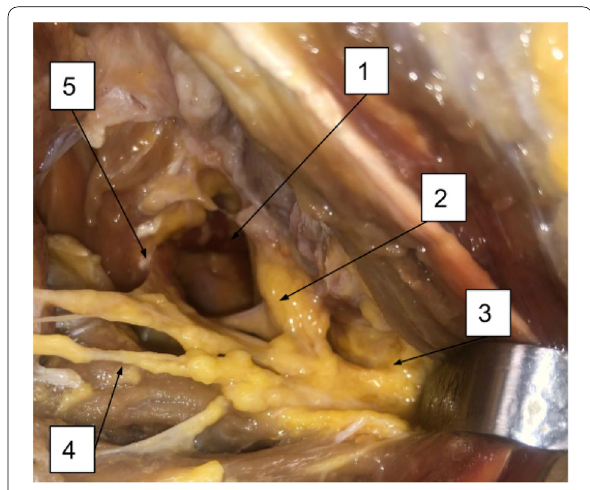
Fig. 6 Posterior approach. (1) Quadrangular space; (2) Axillary nerve; (3) Muscular branch to the deltoid muscle; (4) Muscular branch to the teres minor muscle; (5) Articular branch of the axillary